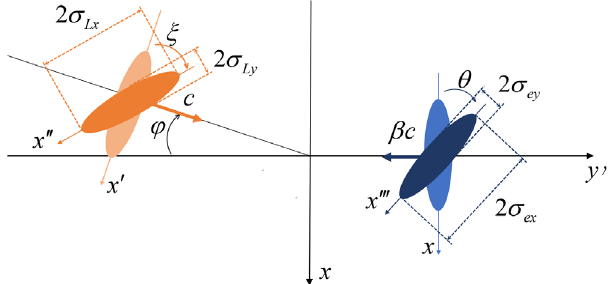
FIG. 2. The layout of the process of inverse Compton scatter- ing; both photon (left, orange) and electron beams (right, blue) have direct fronts: the fronts are perpendicular to the trajectories.